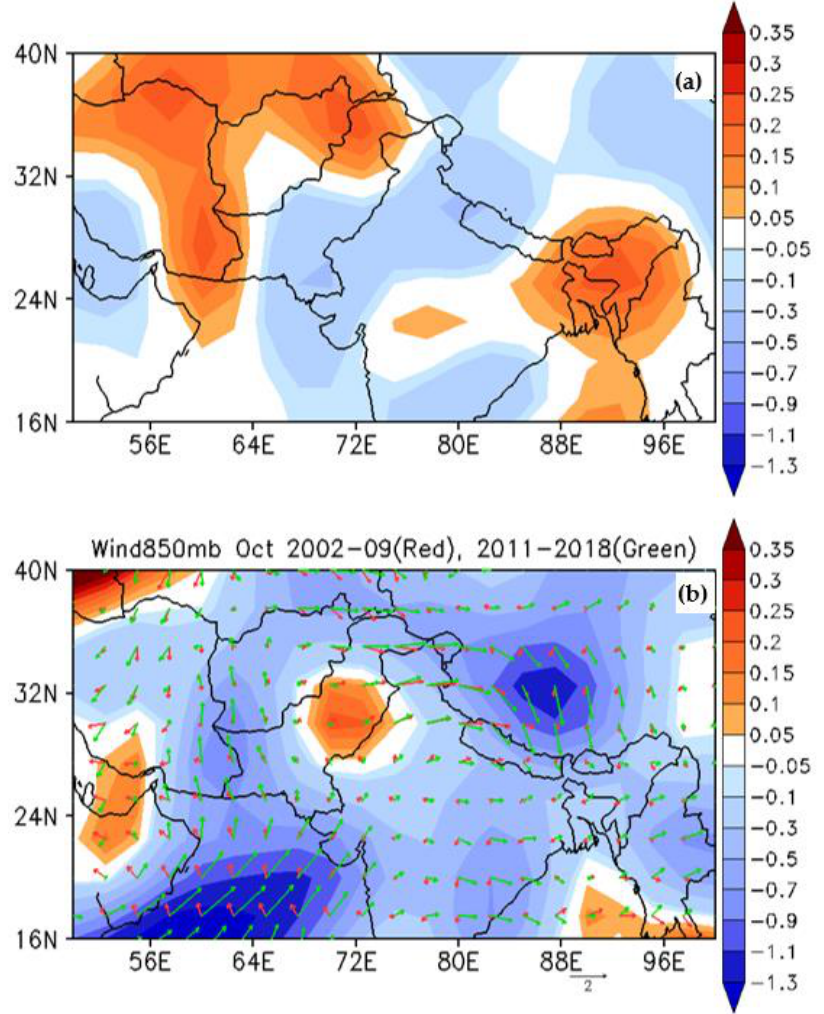
Figure 5. October ( a ) Vertical velocity (Omega at 900 mb) ( b ) Winds for two periods and difference in the magnitude of 2002 – 2009 (wind in red) to 2011 – 2018 (wind in green).